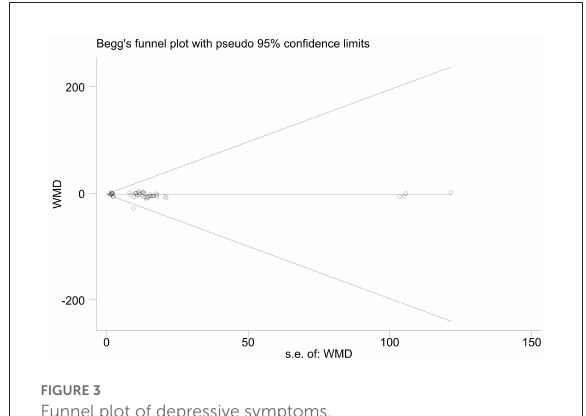
FIGURE3 Funnel plot of depressive symptoms.